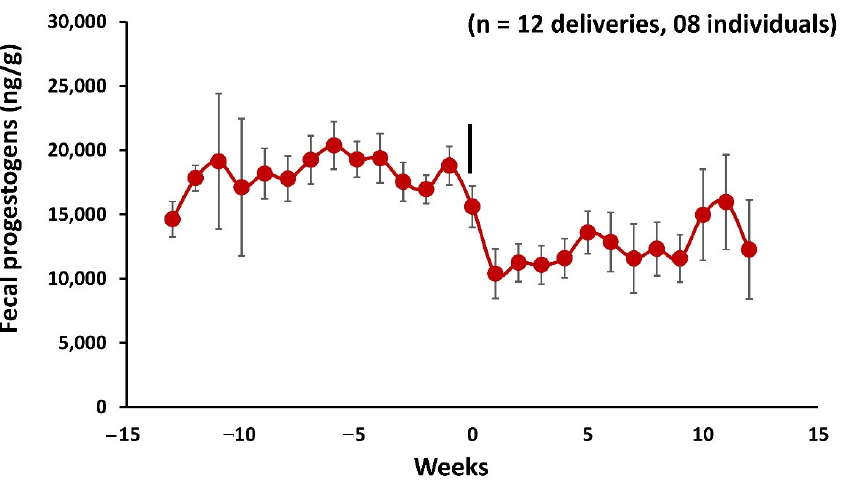
Figure 11. Profile of mean ± SEM weekly fecal progestogens in mouse deer during 11 weeks before and after parturition. The zero week and vertical bars indicate the parturition, mating, and postpartum estrus (n = 12) were recorded in eight individuals.